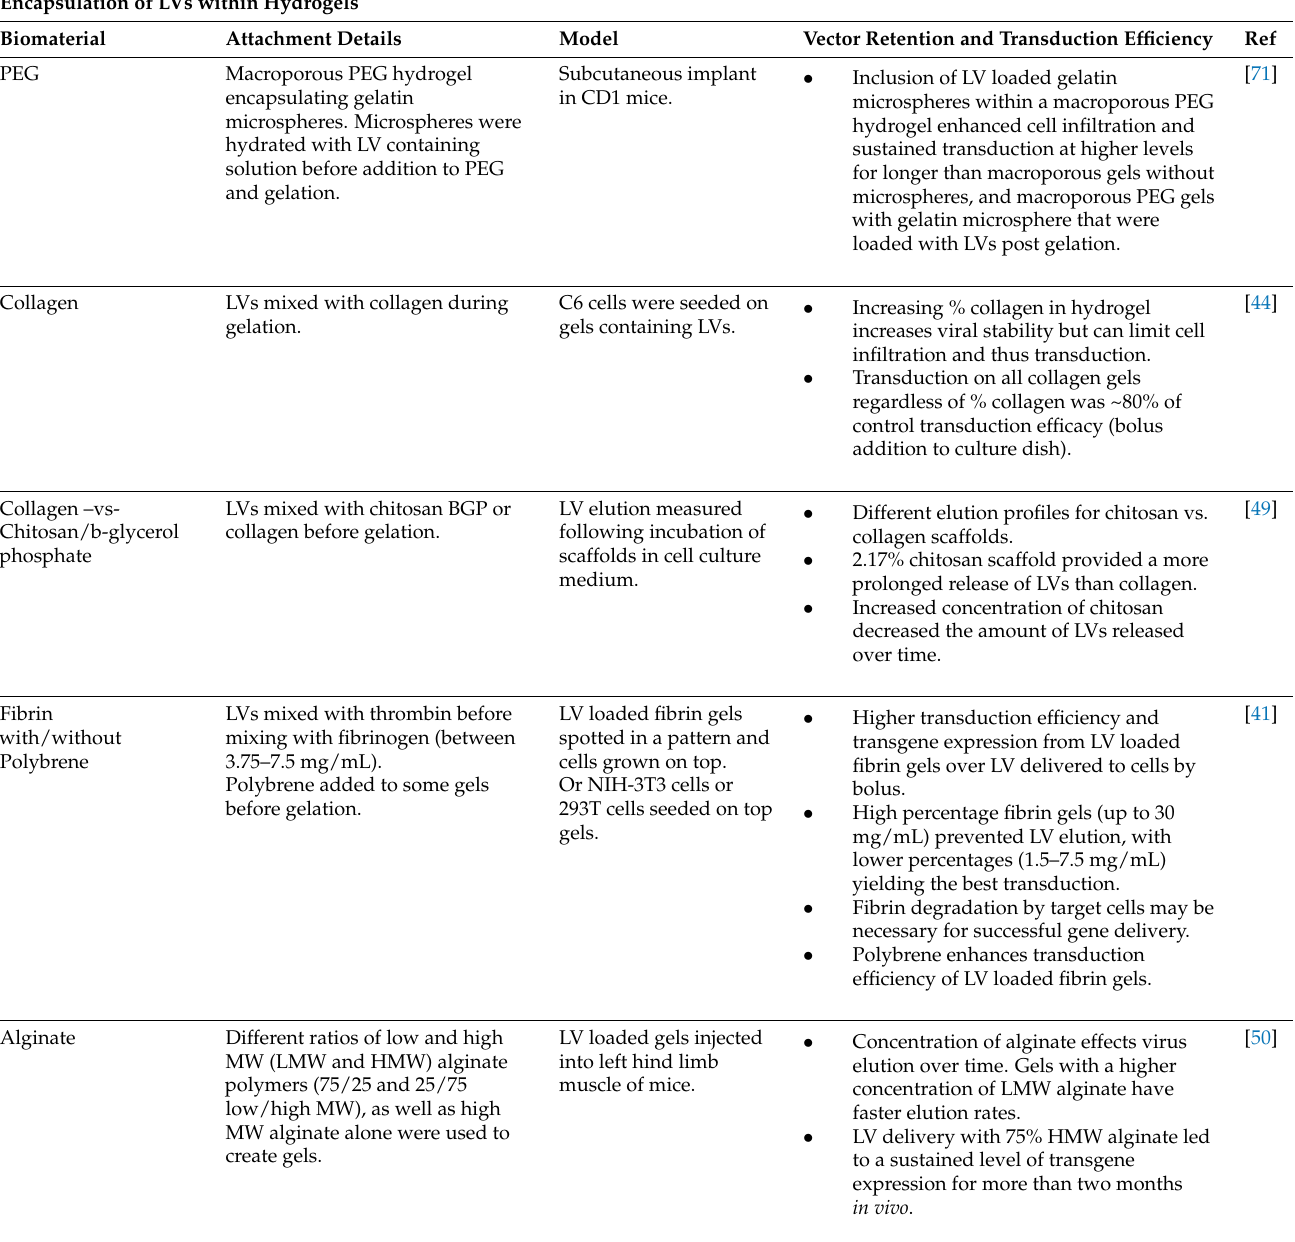
Table 3. Studies using encapsulation of LV within a hydrogel for delivery. Chitosan BGP; chitosan/b-glycerol phosphate, EG; Polyethylene (glycol), HyA; Hyaluronic Acid, PLL; poly- L -lysine, MW; Molecular Weight. Encapsulation of LVs within Hydrogels Biomaterial Attachment